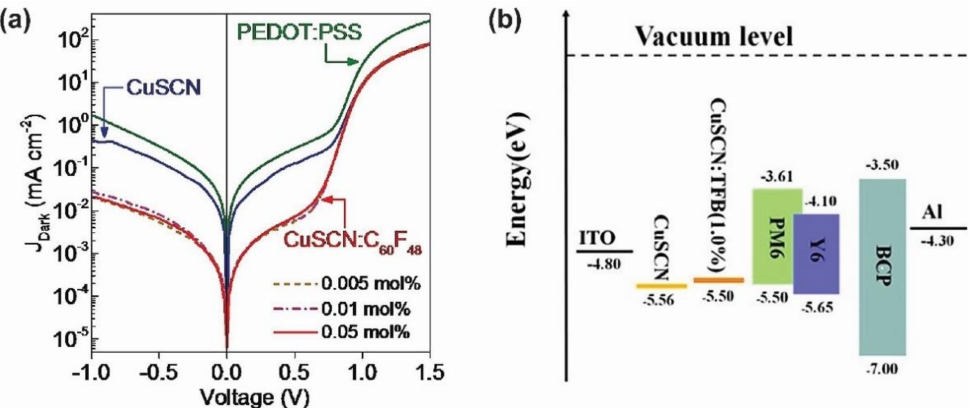
Figure 10. ( a ) J-V curves of CuSCN:C 60 F 48 under dark conditions. Adapted with permission from [213]. Copyright 2018, John Wiley and Sons. ( b ) Energy level alignment of ITO/CuSCN, CuSCN:TFB(1.0%)/PM6:Y6/BCP/Al OSCs. Adapted with permission from [214]. Copyright 2020, American Chemical